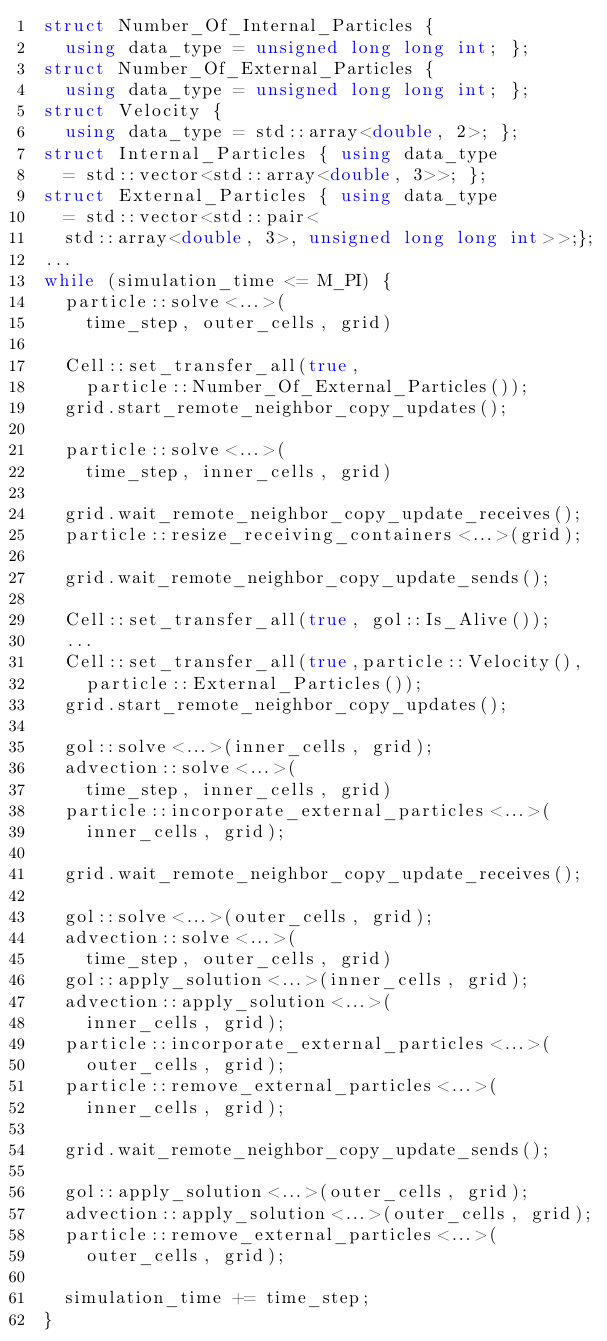
Listing 6. Illustration of the time stepping loop of a parallel pro- gram playing Conway’s Game of Life, solving the advection equa- tion and propagating particles in an external velocity field. Code from parallel advection simulation (Listing 5) did not have to be changed. Variables of the particle propagation model are also shown.